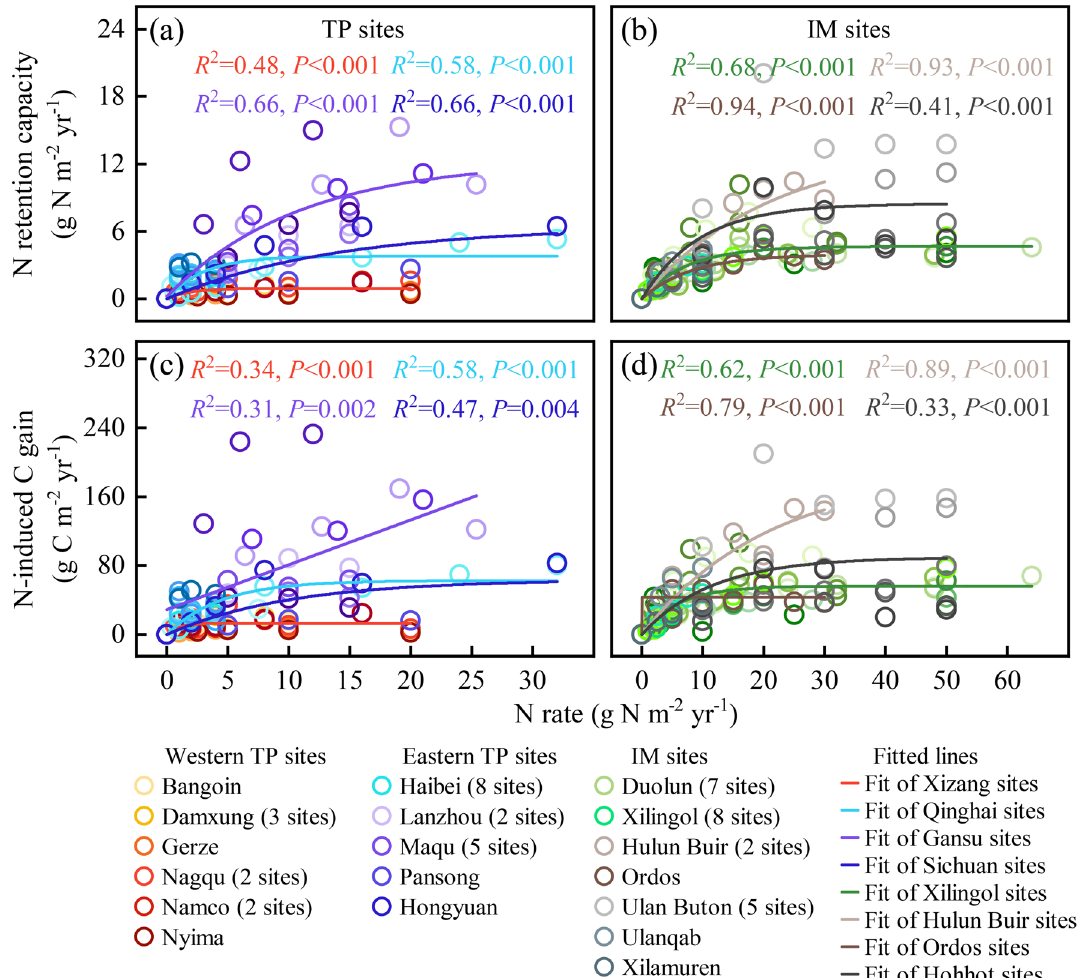
Figure 6. The response of N retention capacity and N-induced C gain in Tibetan Plateau (TP) alpine grassland and Inner Mongolia (IM) grassland. The left panels represent TP sample plots and the right panels represent IM sample plots. Single regression analyses were implemented separately for the western TP (Xizang, n = 49), eastern TP (Qinghai, n = 36; Gansu, n = 29; and Sichuan, n = 10) and four regions in IM (Xilingol, n = 95; Hulun Buir, n = 11; Ordos, n = 7; and Hohhot, n = 30). Full regression results are shown in Appendix S2: Table S9. Points of each color represent a sampling plot and fitting lines of each color represent a